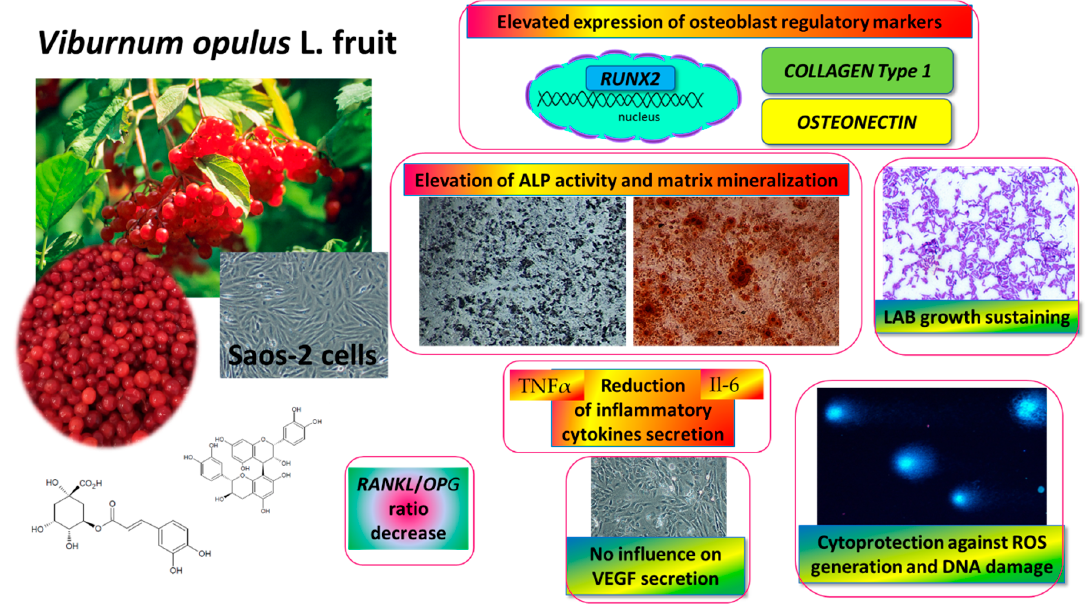
Figure 11. V. opulus fruit juice phenolic compounds as regulators of Saos-2 cell activity-proposed mechanism of action. V. opulus upregulates the mineralization of Saos-2 cells with an increase in the expression of the RUNX2 transcription factor; diminishes the release of TNF α and Il6 inflammatory cytokines; possesses cytoprotective activity against ROS generation and DNA damage; sustains lactic acid beneficial microorganism growth.